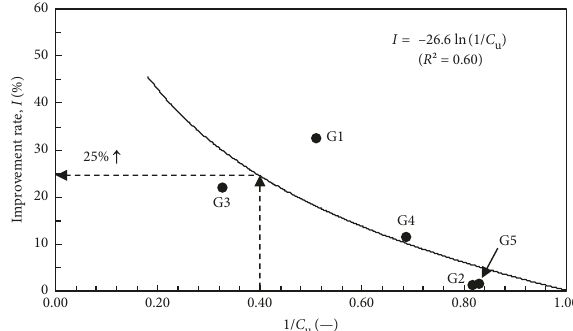
Figure 9: Rate of increase in the rate of removal volume according to 1/ C